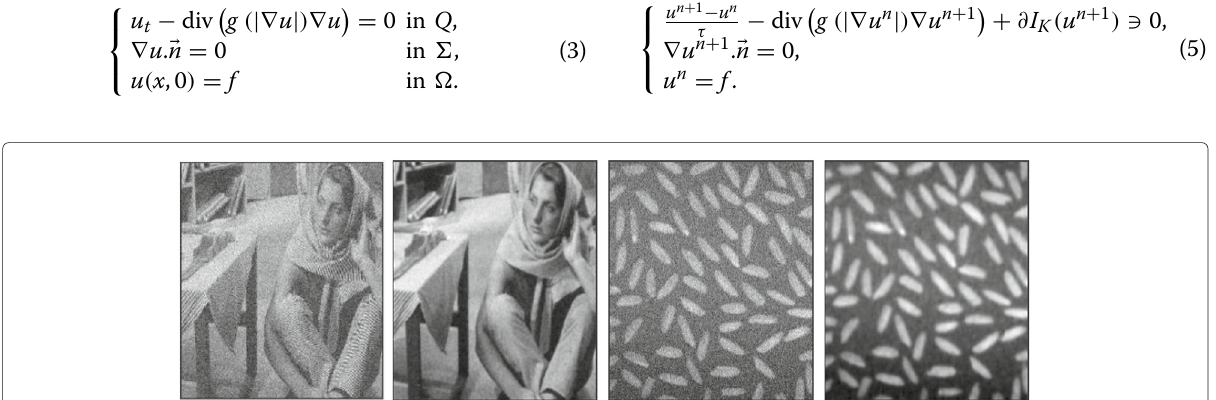
Fig. 5 Lefttoright: noisy Barbara image, restored Barbara image by our algorithm, noisy rice image, restored rice image by our